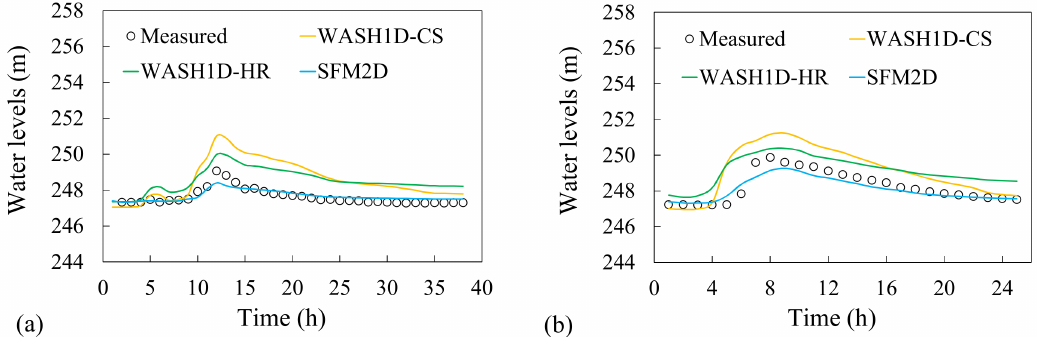
Figure 11. Comparisons of the measured and simulated water levels obtained using three approaches at the Shuiwei gauging station for ( a ) Typhoon Nesat and ( b ) Typhoon